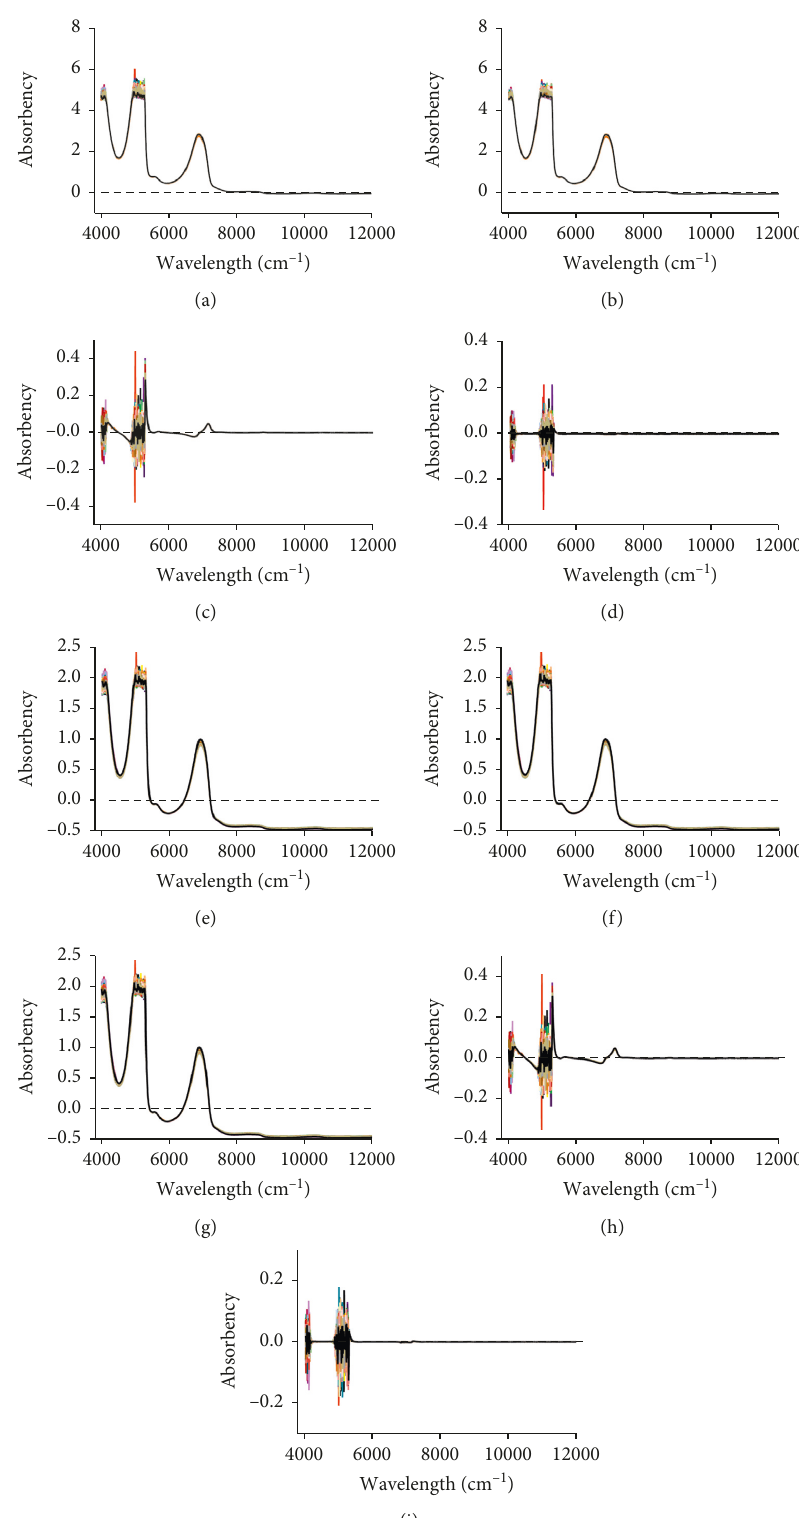
Figure 3: Comparison of the spectrum pretreatment results of Tween-80. Raw NIR spectra of full wavelength (a) and spectra preprocessed using SG smoothing (b) and one-dimensional convolution (c), two-dimensional convolution (d), multiplicative scatter correction (e), standard normal variable transformation (f), normalization method (g), one-order derivative convolution+multiplicative scatter correction (h) and two-dimensional convolution+multiplicative scatter correction